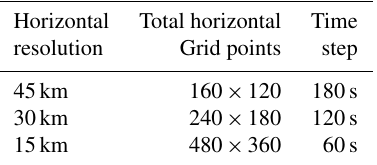
Table 1. Horizontal resolutions and time steps of WRF. Horizontal Total